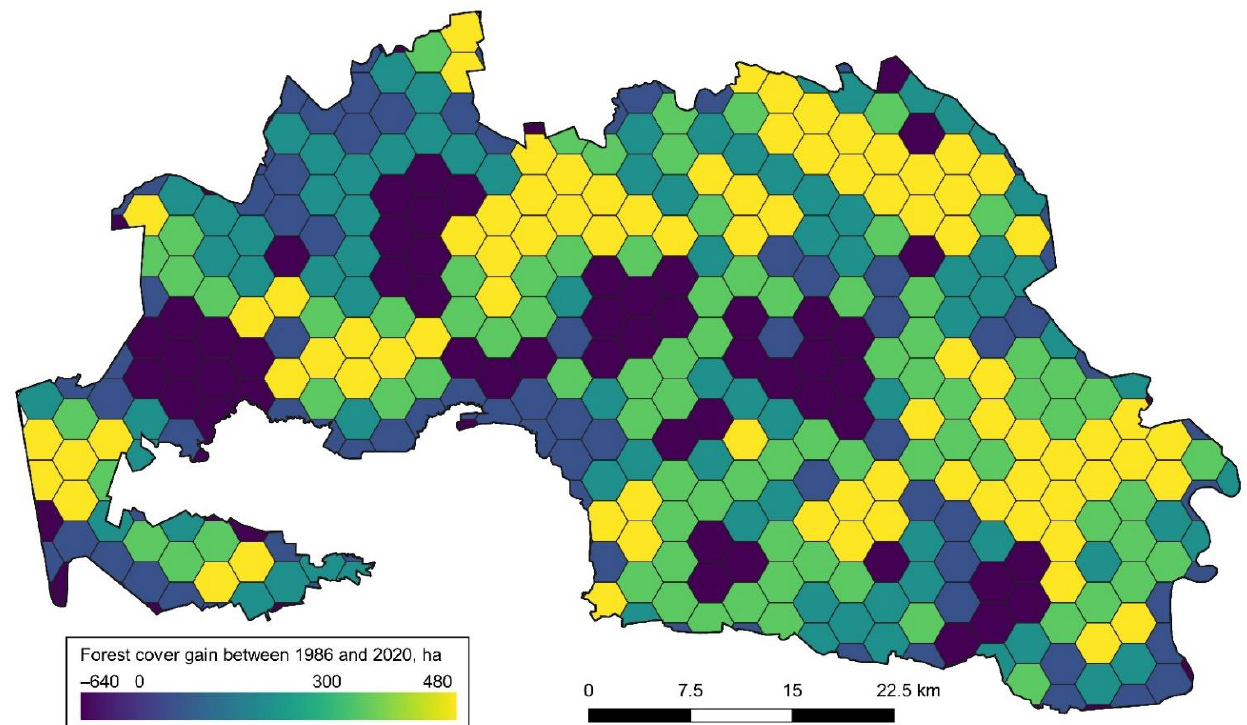
Figure 5. Land cover dynamics (1986 – 2020) predicted by the classification model applied to the LT-fitted spectral data set.